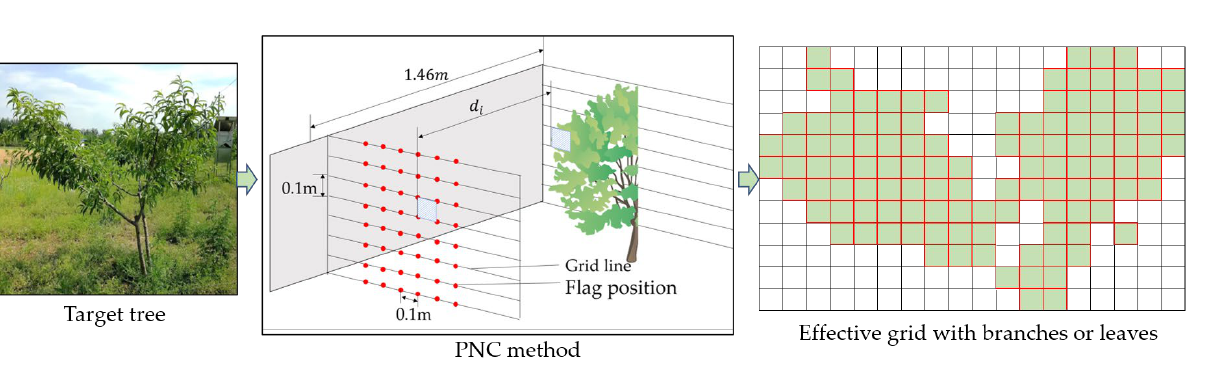
where V manual is the fruit tree canopy volume, m 3 ; d i is the distance between the outermost canopy and the mesh plane m; and A i is the single mesh area in m 2 .